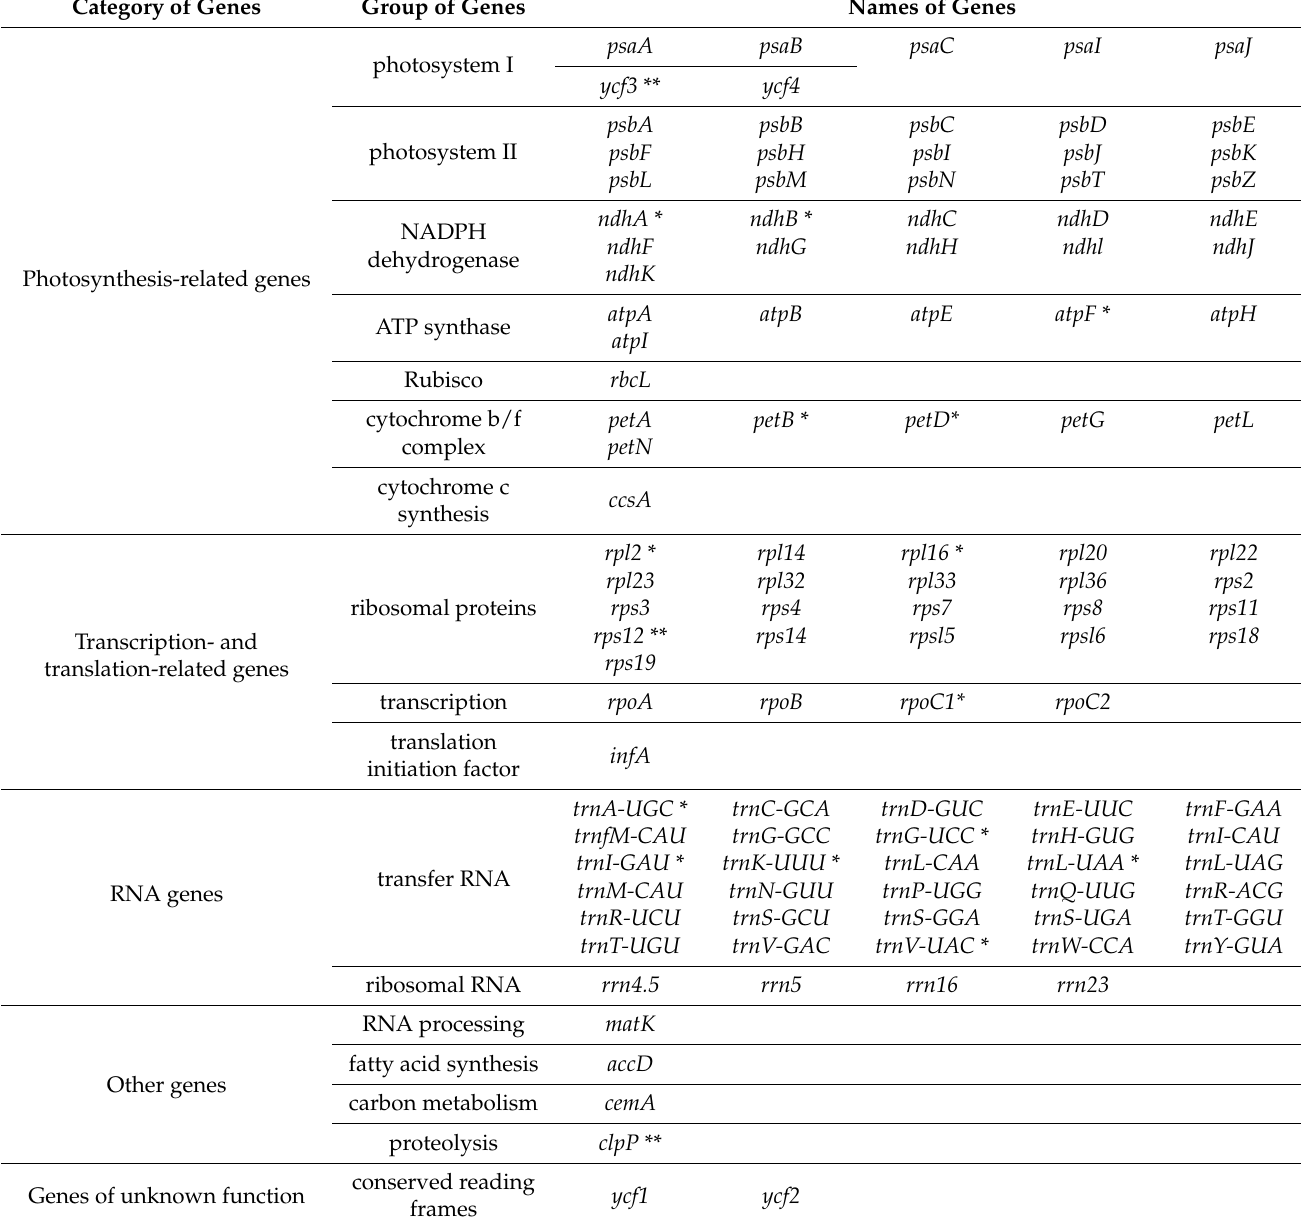
Table 2. Genes in the chloroplast genomes of the two Euonymus maackii Rupr. species. Category of Genes Group of Genes Names of